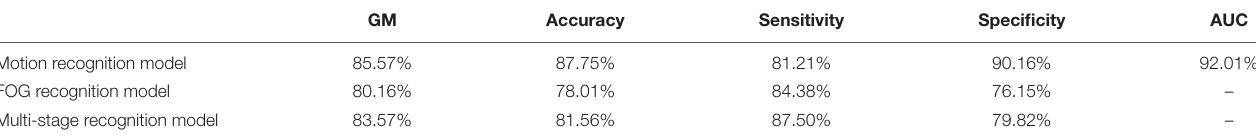
TABLE 6 | Performance of each model.